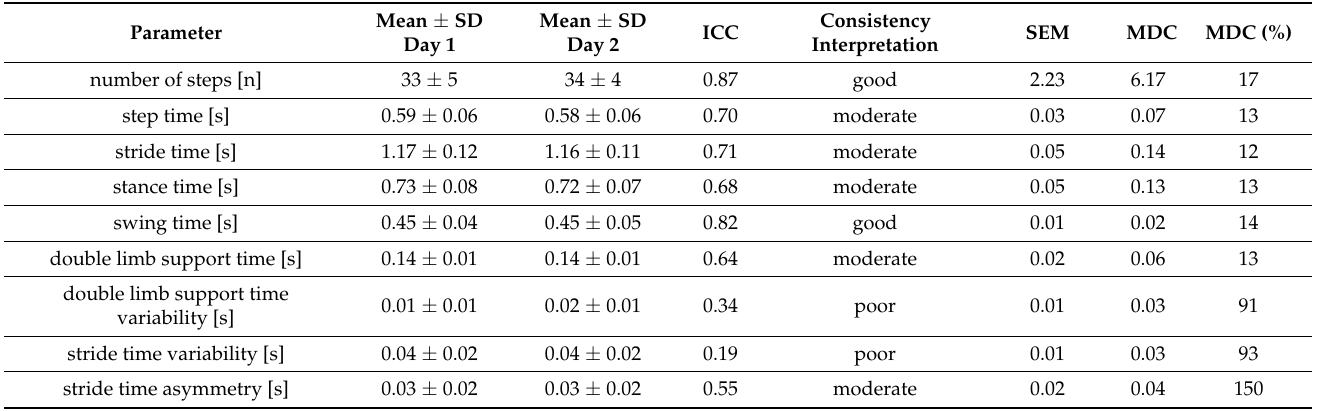
Table 2. Reliability and minimal detectable change: 20 m walking